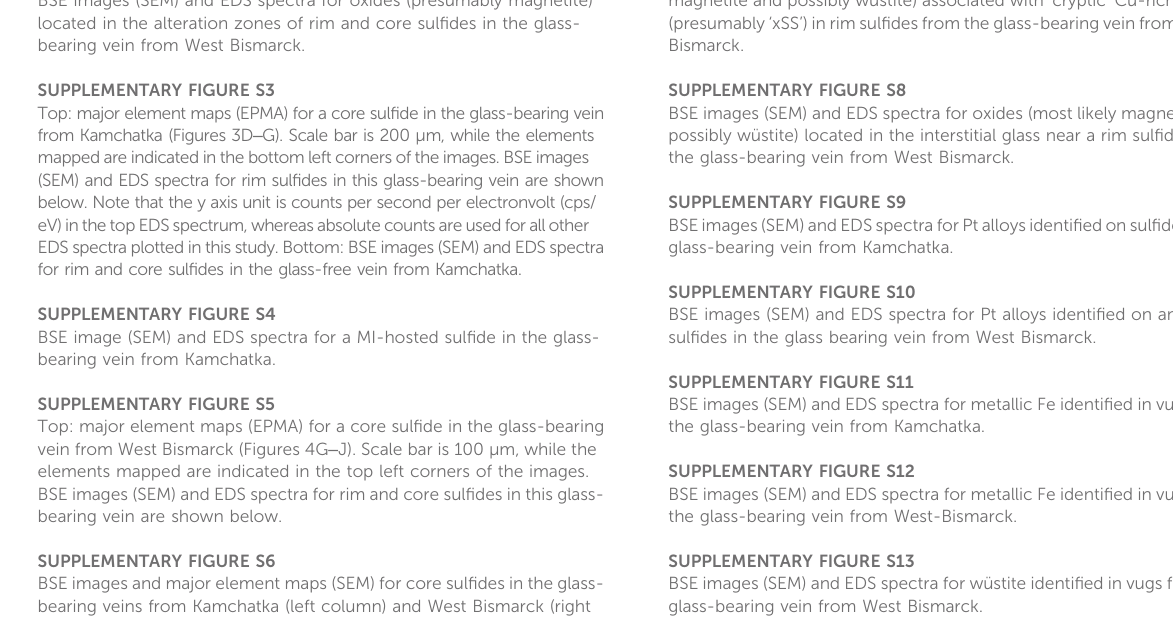
glass-bearing vein from West